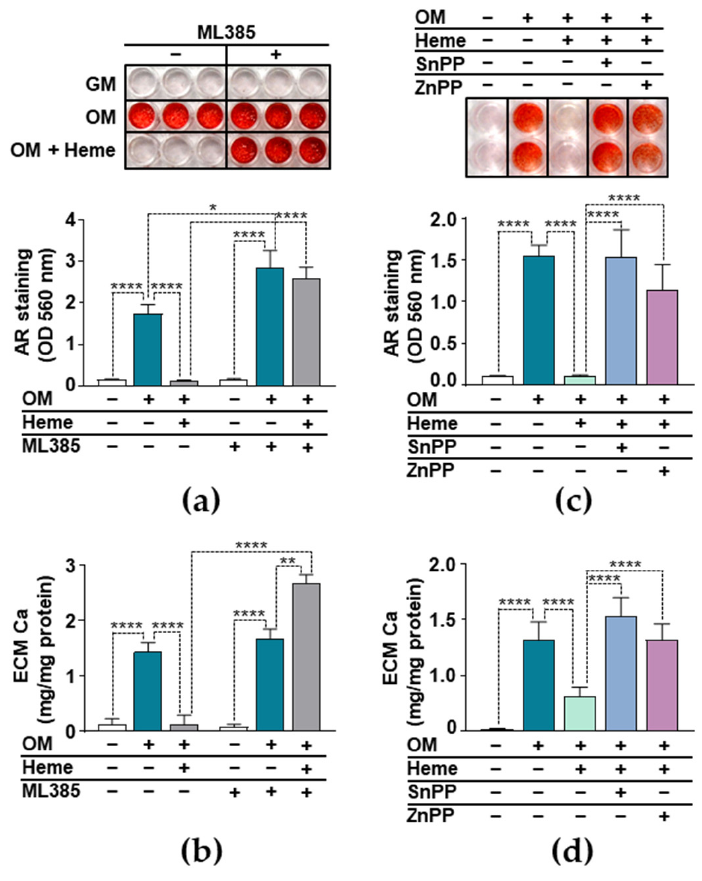
Figure 4. Inhibition of Nrf2 or HO-1 diminishes the anti-calcification effect of heme. ( a , b ) VICs (passage number 5–8) were pretreated with vehicle or ML385 (10 µ mol/L) for 3 h. ( c , d ) VICs were pretreated with vehicle, SnPP (10 µ mol/L), or ZnPP (10 µ mol/L) for 3 h. ( a – d ) After the pretreatment, cells were maintained in GM, OM, or OM supplemented with heme (10 µ mol/L). ( a , c ) Representative AR staining from three experiments and quantification (day 5) are shown. ( b , d ) The Ca content of the HCl-solubilized ECM is presented (day 5). Data are expressed as mean ± SD of three independent experiments performed in triplicate. * p <0.05, ** p <0.01, **** p